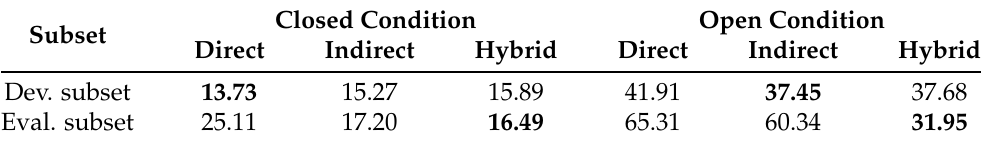
Table 3. AER (%) results for the Albayzín 2020 corpus. Results of direct and indirect assignment as well as the hybrid systems, including results for both development and test subsets. Experiment corresponding to closed and open conditions.